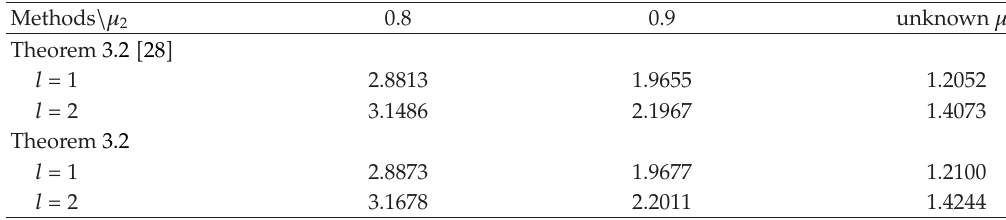
Table 3: Calculated MAUBs τ (cid:8) 0 . 5 in Example 4.1. max for various l and μ 1 Methods \ μ 2 0 . 8 0 . 9